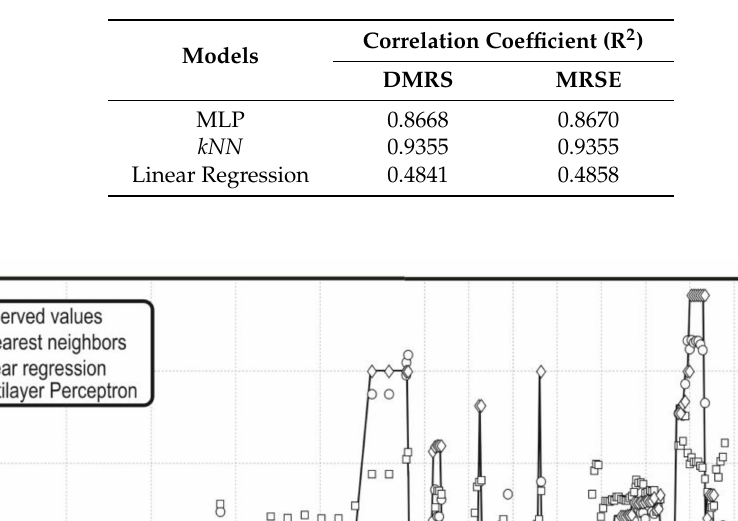
Table 3. Model correlation coefficients based on plane and space figures of merits.